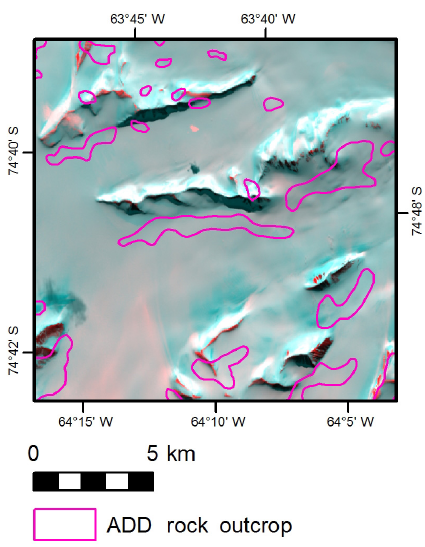
Figure 1. Example of the issues with the existing ADD rock outcrop dataset showing the problems with the georeferencing, overestima- tion and generalisation of areas of rock outcrop. The example uses a false-colour image using the band combination red: SWIR2; green: blue; and blue: blue. This combination accentuates rock, snow and cloud distinctions, with red/pink pixels representing rock or clouds and turquoise pixels representing snow. The Landsat 8 scene used is